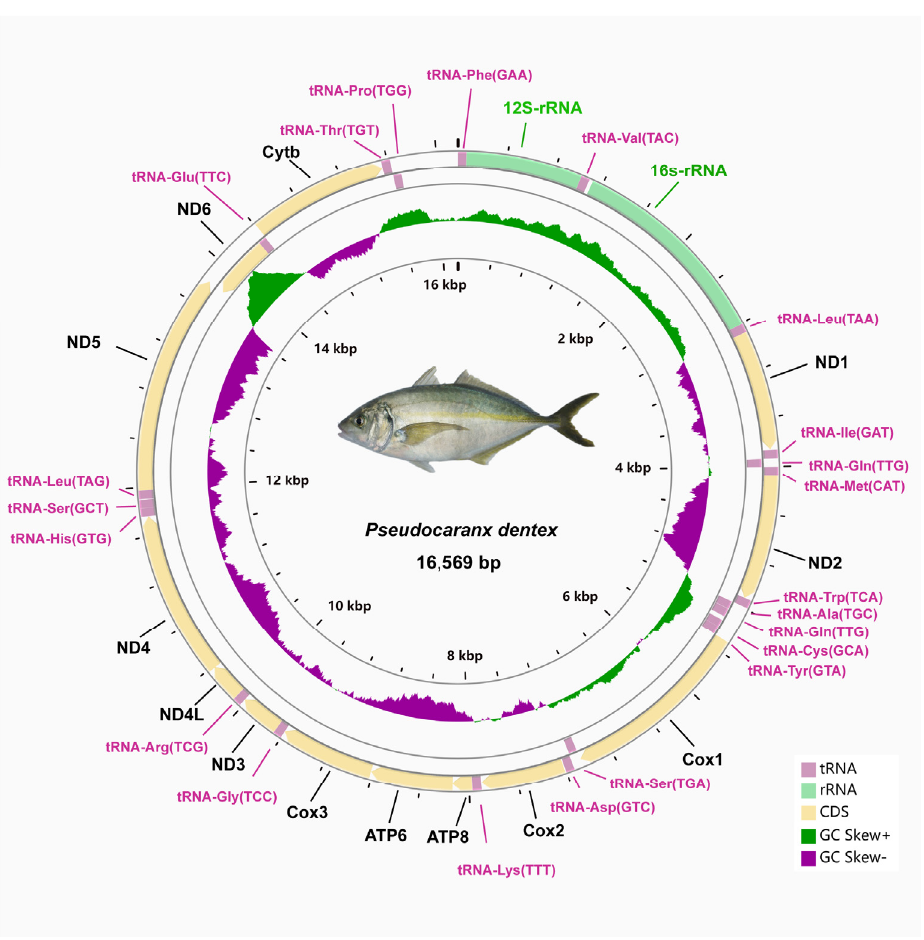
Figure 1. Circular mitochondrial genome map of P. dentex . The larger circle indicated the gene arrangement and distribution. Genes encoded by the H-strand and L-strand were displayed in outside and inner rings, respectively. The smaller circle indicated GC- and AT-skew distribution. Table 2. Genome features of P. dentex .